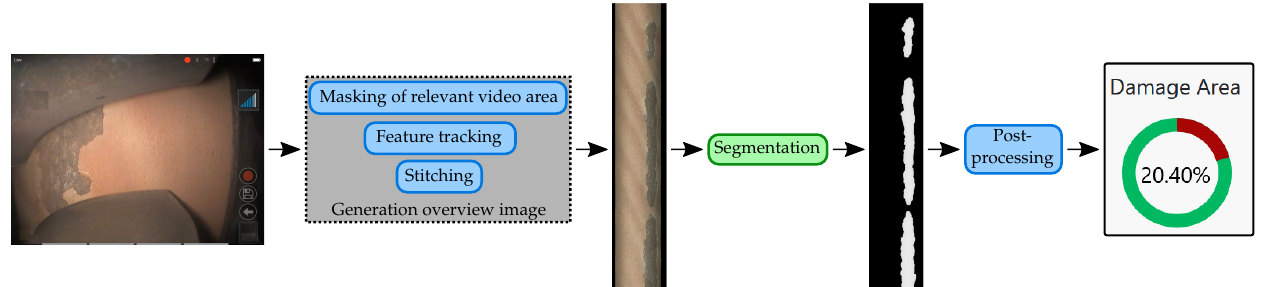
Figure 1. Visualization of the pipeline implemented in the resulting software tool. Here, the video (on the left) is inserted, processed and evaluated by the segmentation algorithms. After a subsequent postprocessing, a relative damage quantification and a visualization of the whole coating area and the detected damages are provided. The overview image (center) is depicted considerably smaller in height than originally. The proposed methods are implemented in the Segmentation block